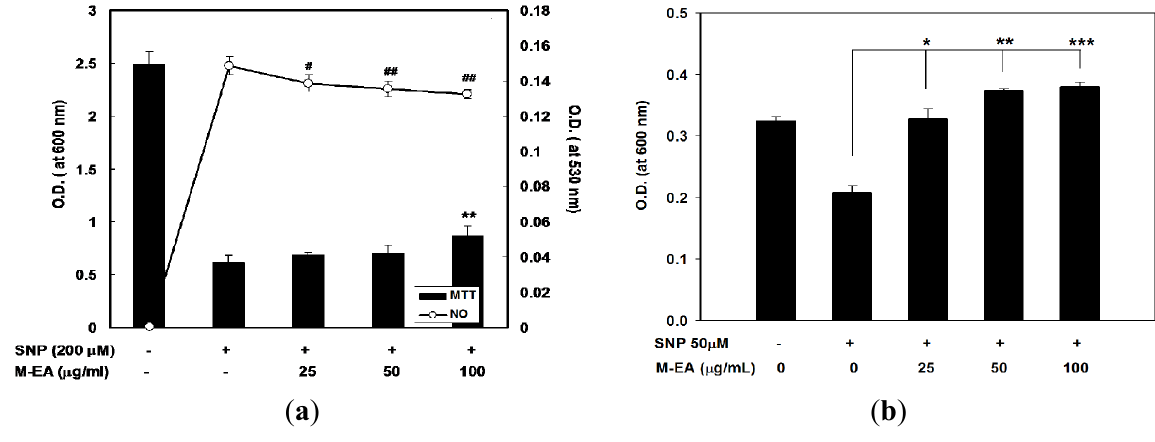
Figure 6. Preventive effects of M-EA on SNP-treated RAW 264.7 cell ( a ) and splenocyte ( b ) death. SNP-induced cytotoxicity was detected by an MTT assay (at 600 nm), and the NO level of the culture medium in RAW 264.7 cells was determined by the Griess reagent (at 530 nm). Values (O.D.) are presented as the mean ± SD, n = 3, each with triplicate samples. * p < 0.05, ** p < 0.005.